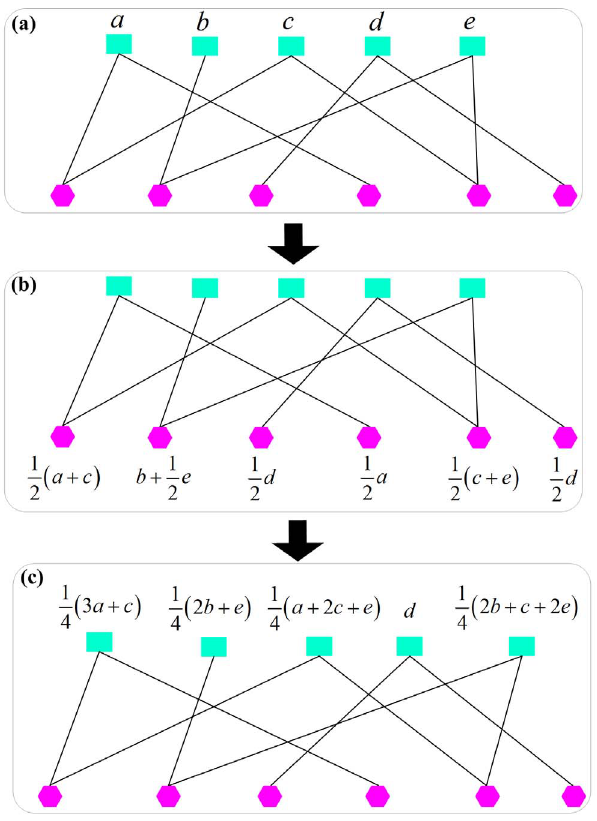
Figure 3. Principle of the resource-allocation process in a bipartite network. The green rectangles represent X nodes and red hexagons represent Y nodes. The whole process consists of two steps: First, the resource flows from X to Y (a ? b), and then returns to X (b ? c).